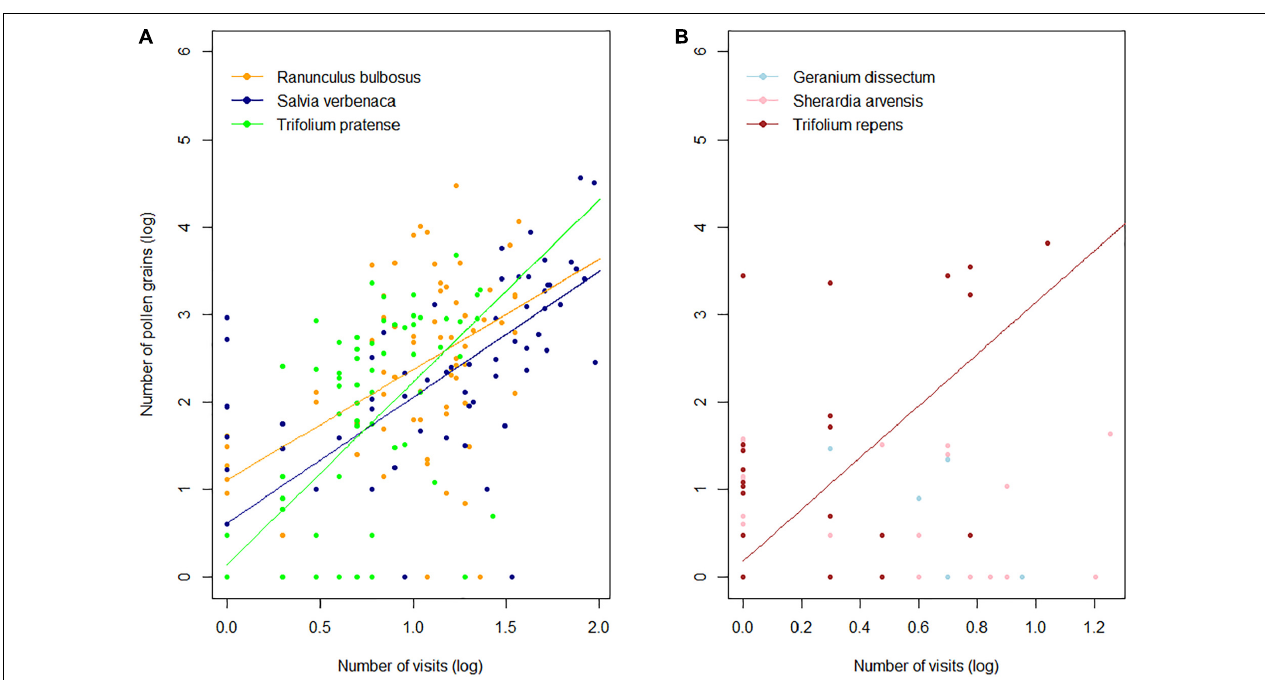
FIGURE 1 | Relationship between pollen abundance in Bombus terrestris pollen loads and the frequency of visits in (A) the frequently visited (linear mixed model; see Supplementary Table 5 for model parameters) and (B) rarely visited plant species (non-parametric Kendall’s correlation). All values were log 10 transformed. ( p = 0.08) was observed, indicating that the slope of the response lines, ranging from 1.26 to 2.08, did not differ